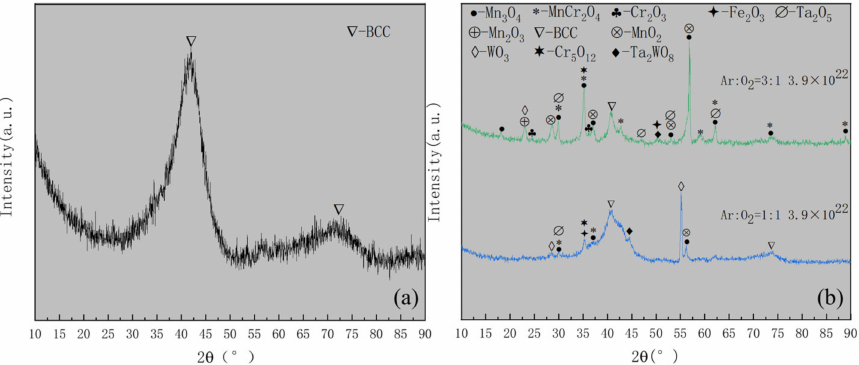
Figure 10. The GIXRD patterns the specimens irradiated with fluence of 3.9 × 10 22 cm − 2 hydrogen ions: ( a ) Cr 20 Mn 17 Fe 18 Ta 23 W 22 ; ( b ) HT1 (Ar: O 2 = 1:1) and HT3 (Ar:O 2 = 3:1)